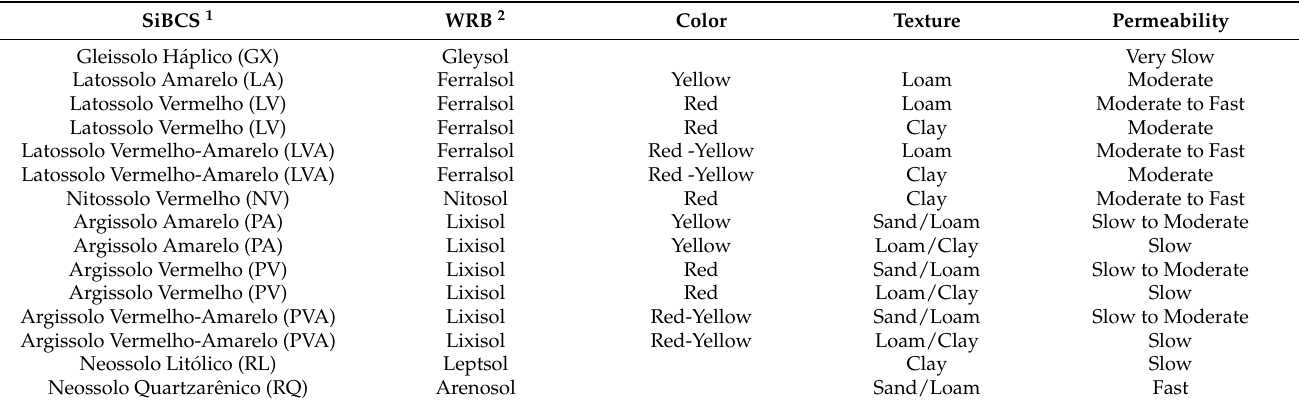
Figure 5. Maps of: ( left ) Lithology, ( middle ) Soil classes, ( right ) Topsoil class texture. Geological map, 1:100.000 scale [59]. Table 5. Permeability according to soil class type, color and texture